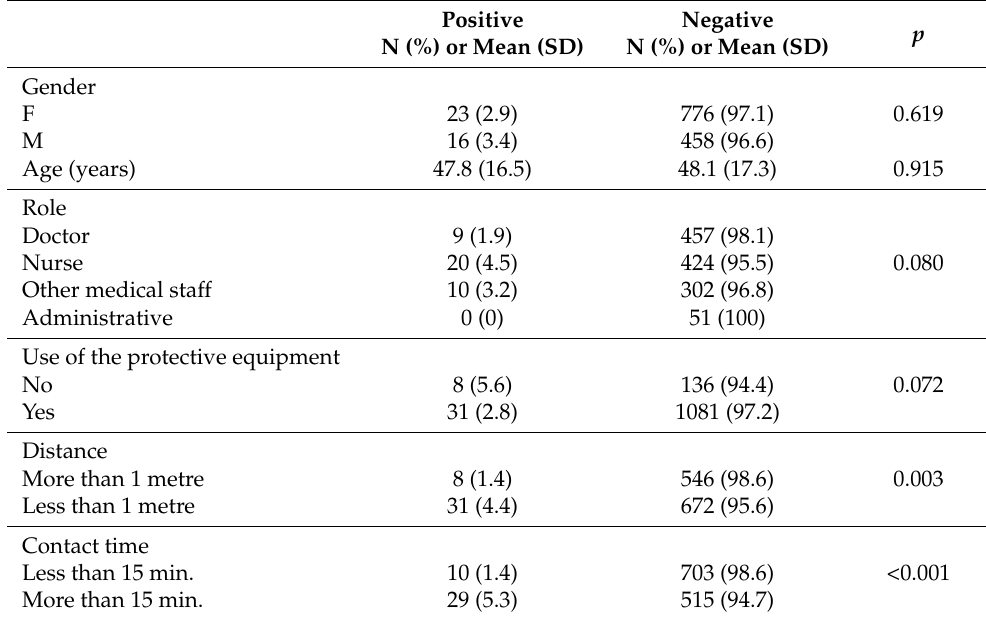
Table 1. The results of the univariate analysis. N = Number of HCWs; SD = Standard deviation.